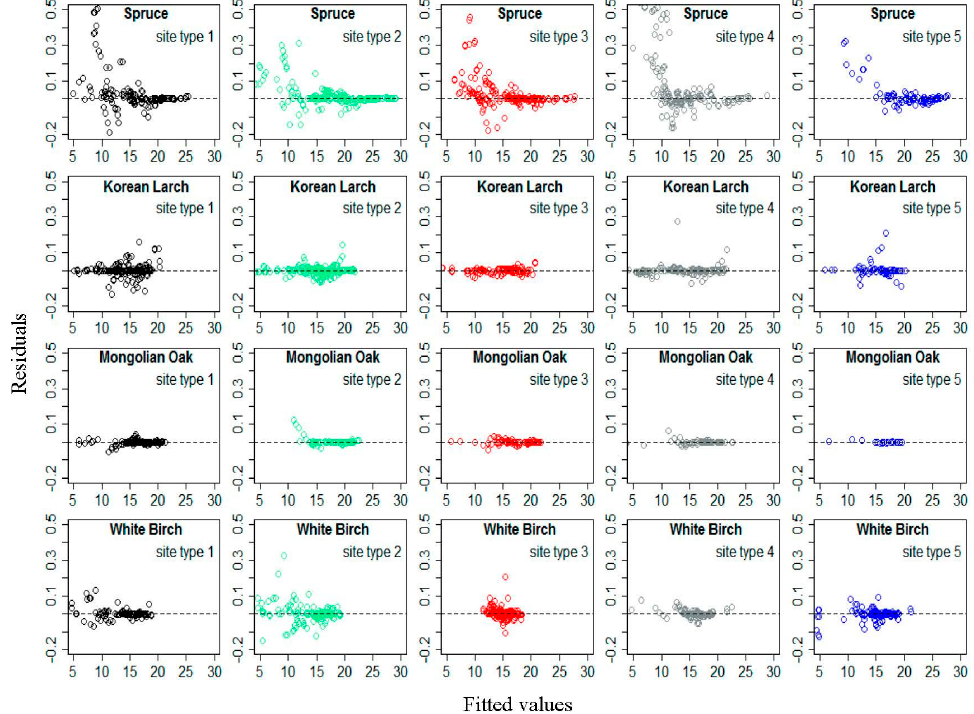
Figure 3. Residual distribution of Equation (16) for Spruce, Korean Larch, Mongolian Oak, and White Birch according to different site type classes.